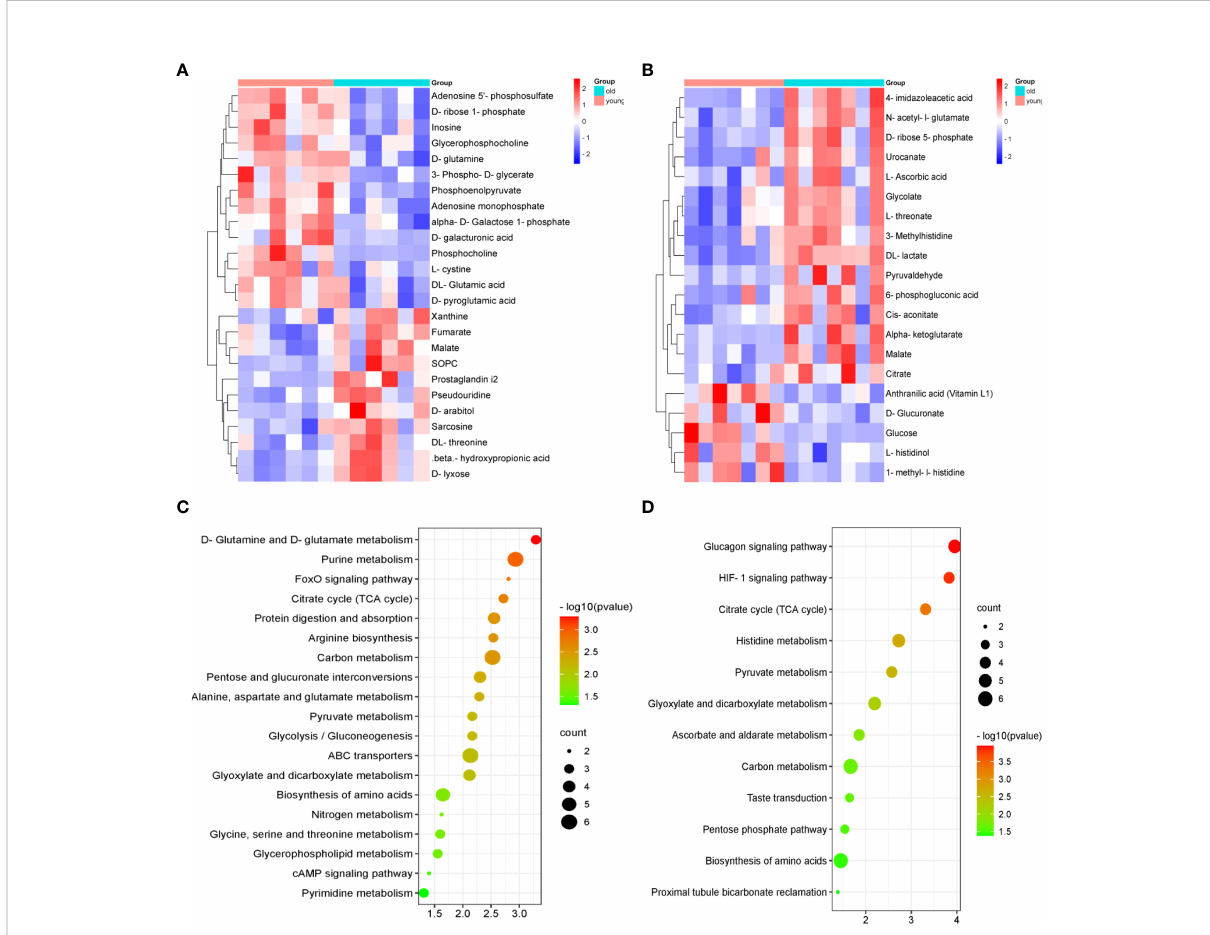
FIGURE 4 The heatmaps of the metabolic pro fi les and analysis of the pathways in the kidney and urine samples. The heatmap of 25 and 20 differential metabolites analyzed using the hierarchical clustering analysis in the kidney samples (A) and urine samples (B) . Summary of the pathway analysis of the differential metabolites represented in the different groups using Metaboanalyst. The size and color of each circle are based on the pathway impact values and p -values in the (C) kidney samples and (D) urine